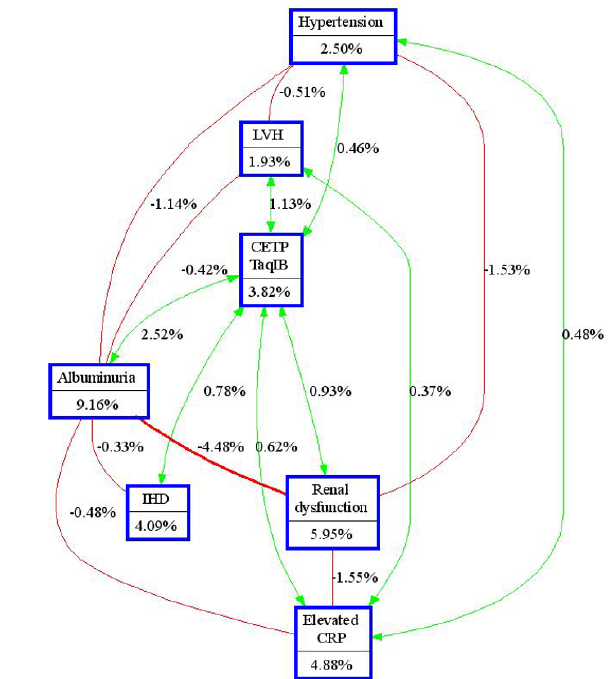
Figure 2 Interaction entropy graph. The interaction models illus- trated in the interaction graph describe the percent of the entropy in case-control status (i.e. presence of atrial fibrilla- tion) that is explained by each factor or two way interaction. Each gene or environmental factor is shown in a box with the percent of entropy below the label. Two way interactions between factors are depicted as an arrow accompanied by a percent of entropy explained by that interaction. Redun- dancy is depicted as a line between factors accompanied by a negative percent of entropy. LVH: Left ventricular